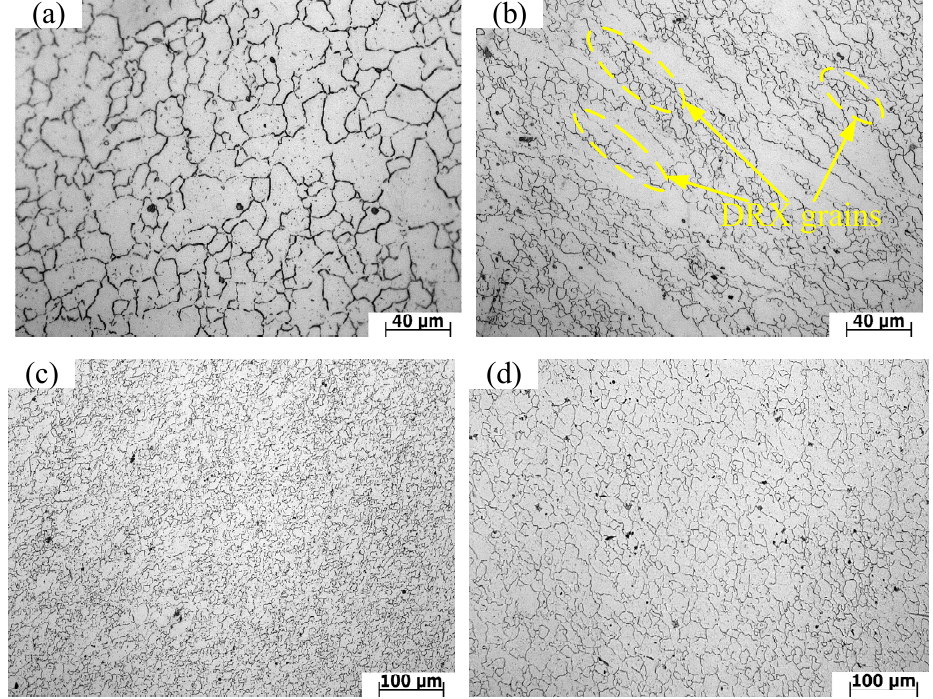
Figure 11. Microstructure of X12CrMoWVNbN10-1-1 alloy steel under various conditions: ( a ) 1100 °C/0.05 s − 1 ; ( b ) 1100 °C/1 s − 1 ; ( c ) 1050 °C/0.1 s − 1 ; ( d ) 1150 °C/0.1 s − 1 .